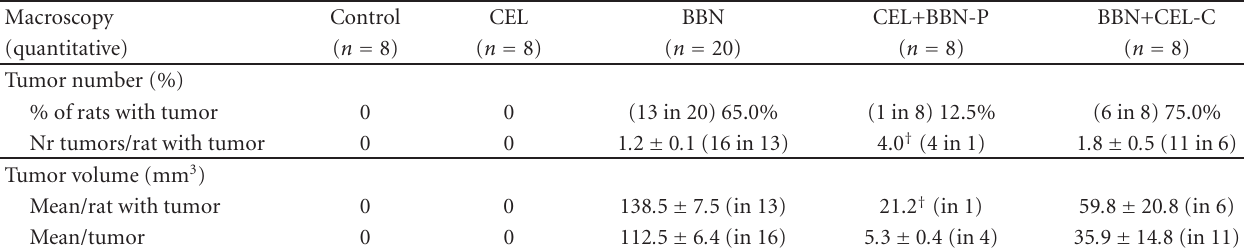
Table 1: The preventive versus curative e ff ect of Celecoxib on bladder cancer: quantitative evaluation of urothelium lesions.